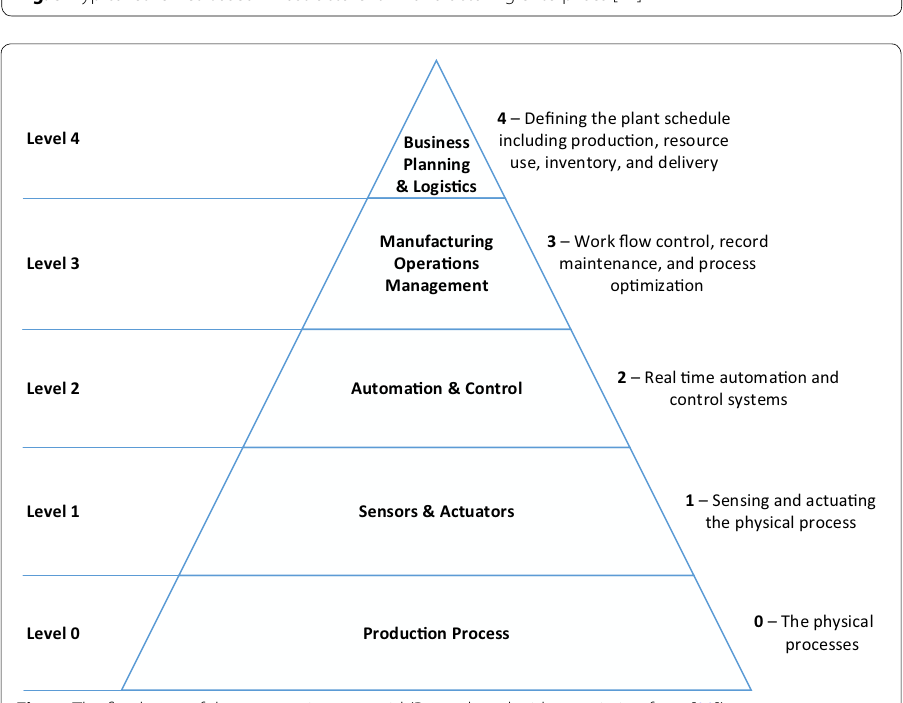
Fig. 3 Typical ethernet‑based infrastructure for manufacturing enterprises [21]